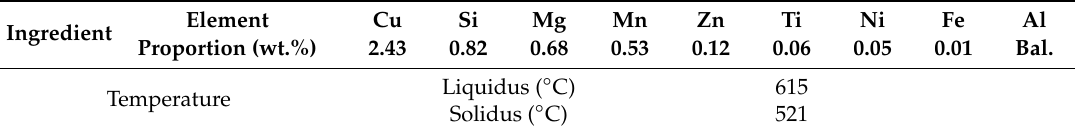
Table 4. Specifications of aluminium alloy 2A50 [5].